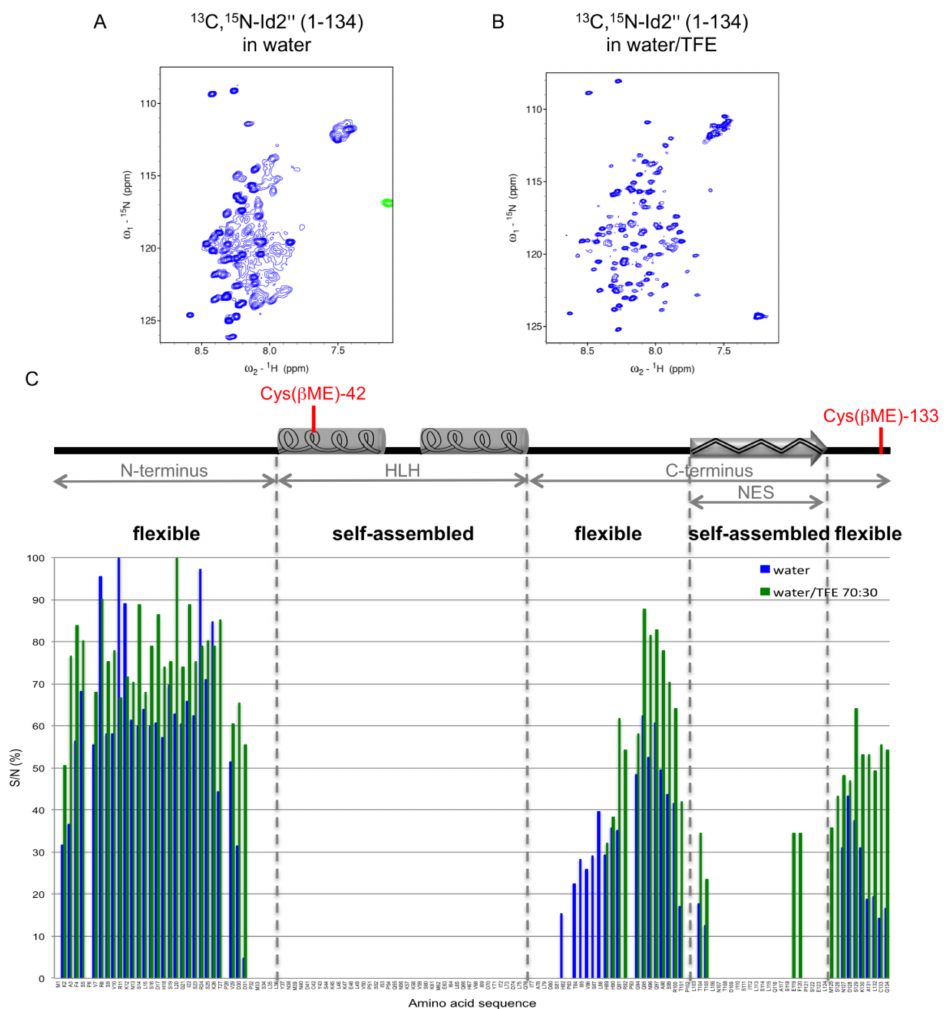
Figure 3. 1 H- 15 N Heteronuclear single quantum correlation (HSQC) spectra of 13 C, 15 N-Id2” in water without or with 30% TFE, at the concentration of 0.86 and 0.5 mM, respectively. ( A ) The spectrum in water (with 7% D 2 O) was measured at 313 K. ( B ) The spectrum in water/TFE (with 7% D 2 O) was measured at 298 K. ( C ) The S/N ratio of the 15 N-H crosspeaks is given in percentage with respect to the highest S/N ratio in each spectrum (Arg-11 or Leu-20 for the spectrum in water or water/TFE, respectively). Chemical shift assignment (ppm) is reported in Tables S2 and